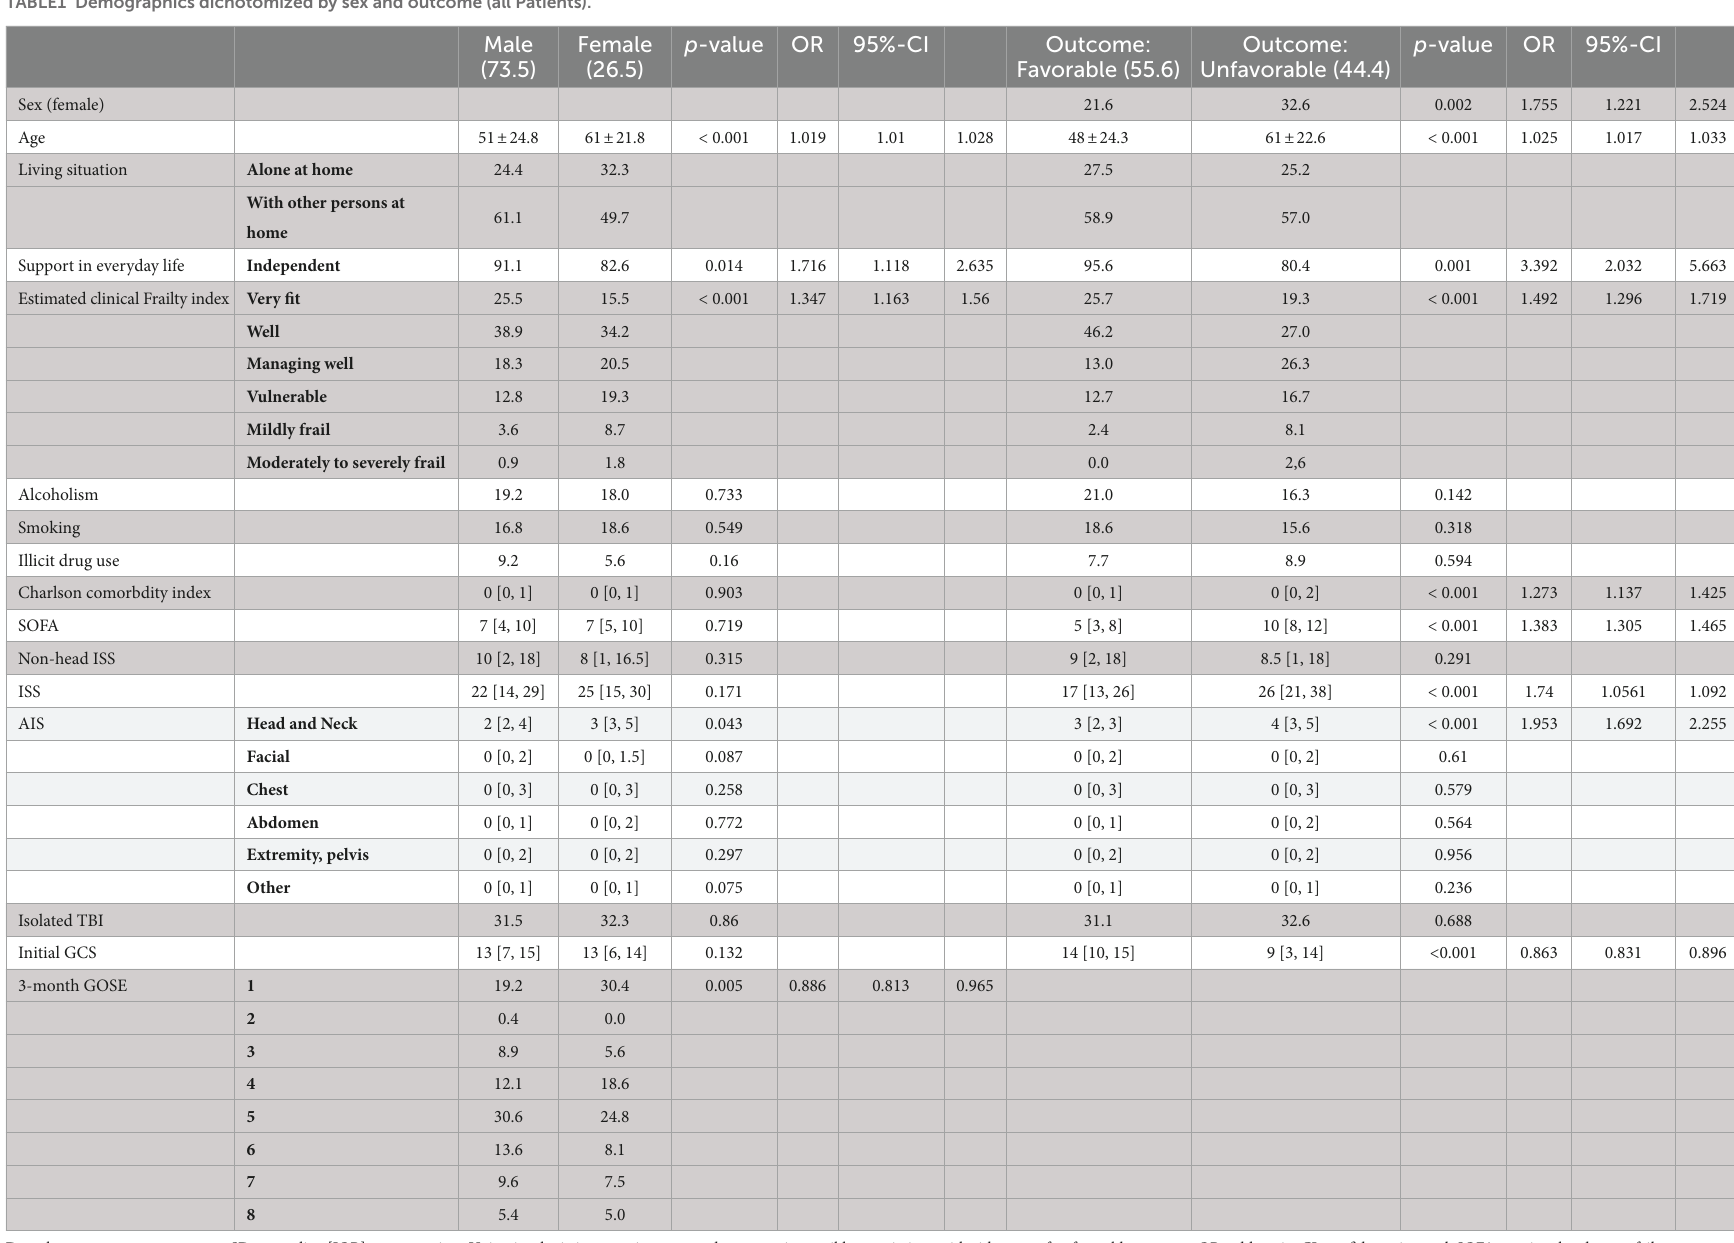
TABLE1 Demographics dichotomized by sex and outcome (all